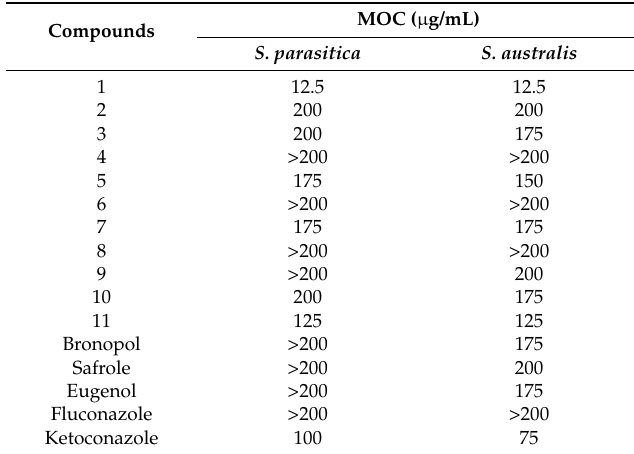
Table 2. Minimum oomycidal concentrations (MOC) values a of oxyalkylchalcones 1 – 11 against mycelium at 48